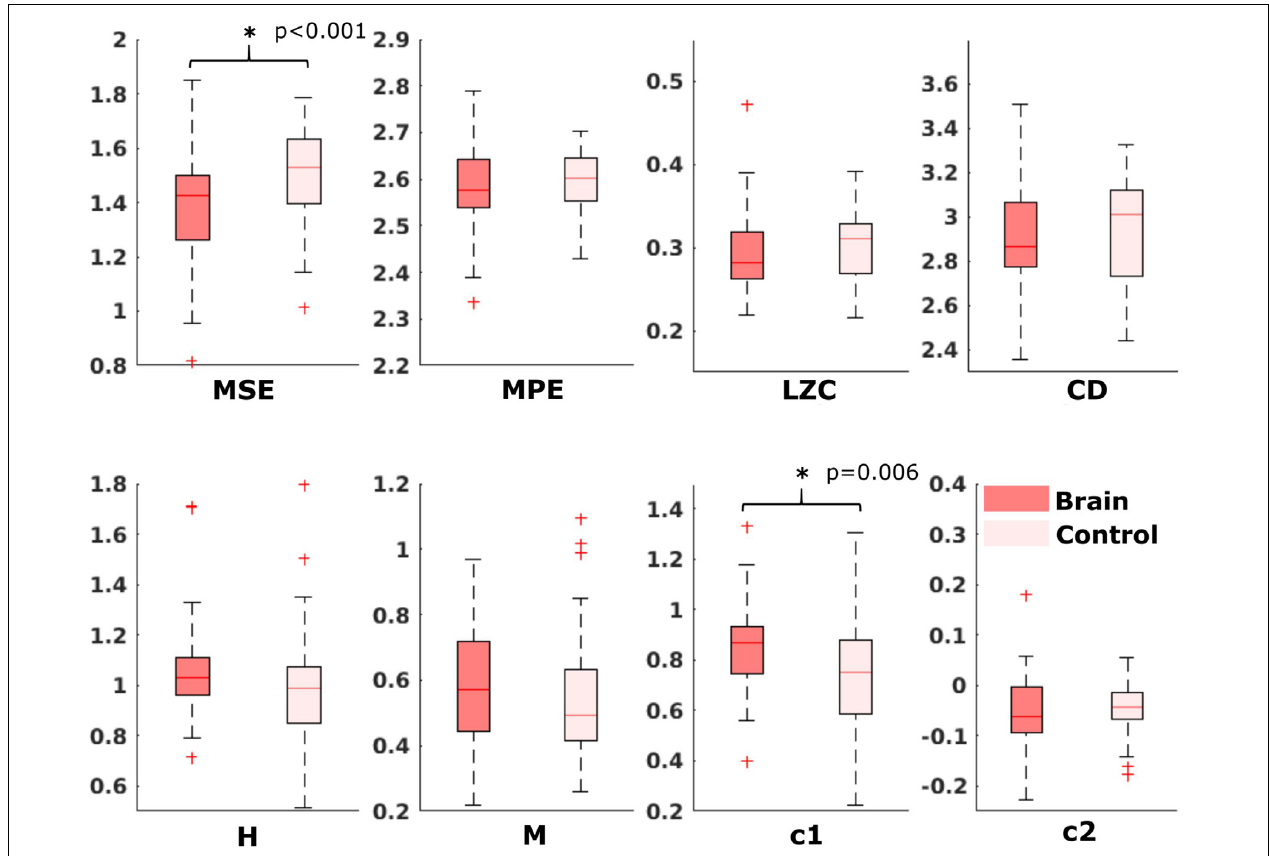
FIGURE 8 | Results from analysis of different metrics on data from fetuses with auditory stimulation. ∗ Depicts significant difference ( p =